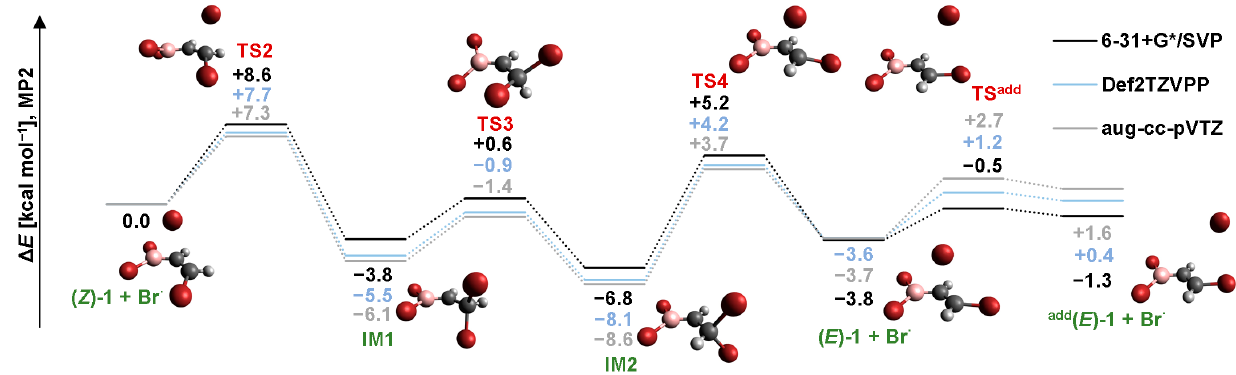
Figure 4. MP2 total electronic energy profile for bromine radical addition to the “bromine end” of ( Z )-1 . For a key to atom color scheme, cf. caption of Figure 1.